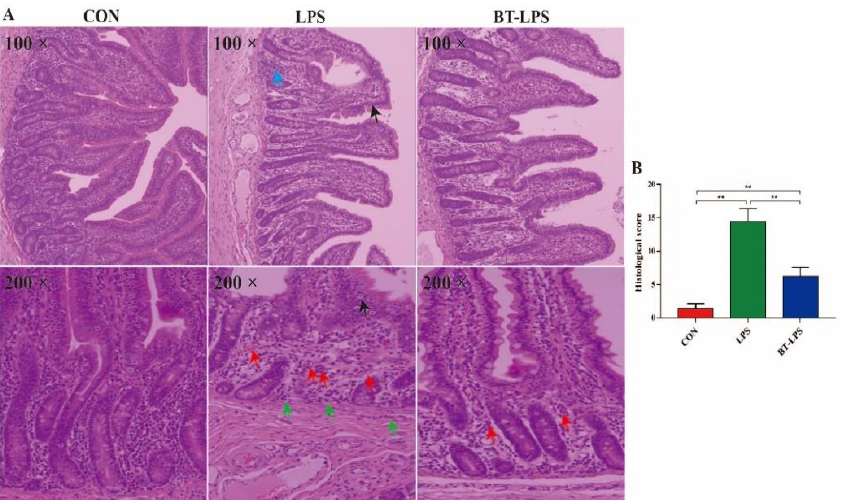
Figure 1. The effects of butyrate on LPS-induced jejunal histology in weaned piglets. ( A ) Representative jejunum histological sections of LPS-induced and butyrate-treated piglets. ( B ) Jejunal histological scores on day 21 based on a 0 – 30 score evaluation system. Arrows in images indicate major histological differences between treatments: intraepithelial lymphocytes (black arrows), granulocyte inflammation (blue arrow), neutrophil inflammation (red arrows), monocyte inflammation (green arrows). Values are the mean ± standard error ( n = 5). ** p < 0.01.